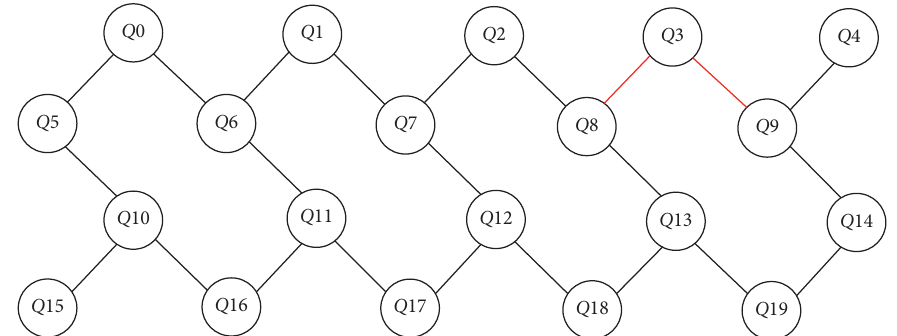
Figure 8: The coupling map picture: Rigetti’s 19-qubit processor “Acorn.” Lines indicate the two-qubit connection ruled by a controlled Z operation.